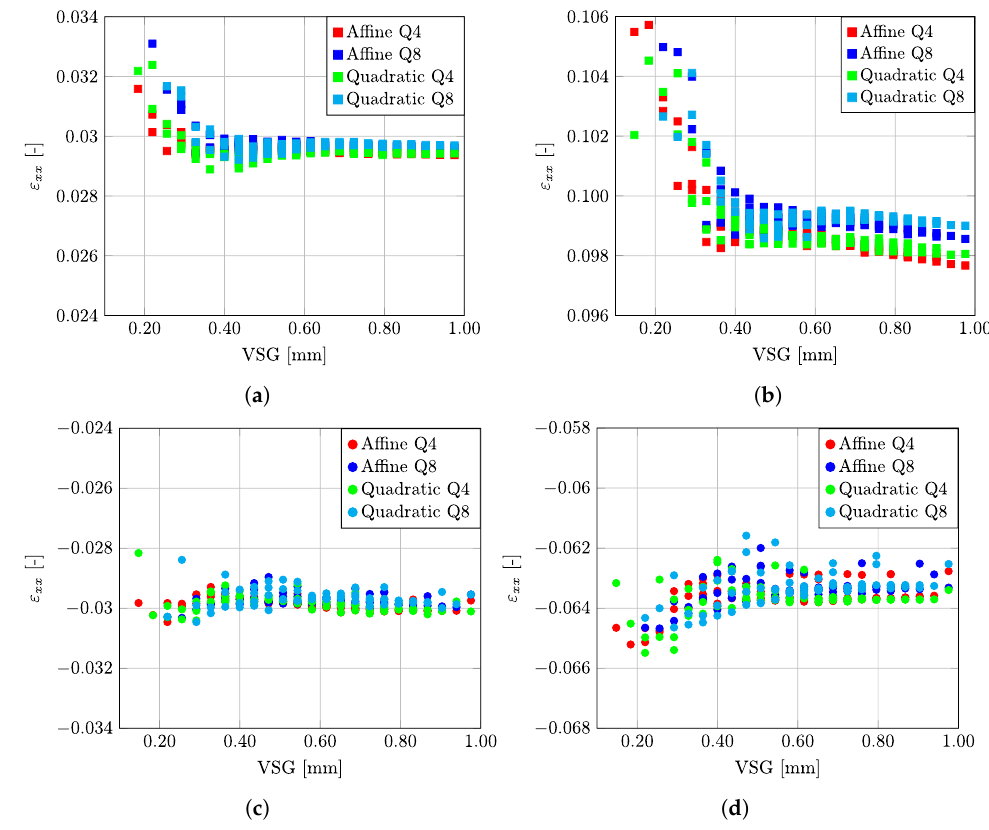
Figure 5. Evaluation of ε xx at point B (Figure 3) as a function of DIC parameters expressed with regard to Virtual Strain Gauge (VSG). ( a ) Tension-Low Strain; ( b ) Tension—High Strain; ( c ) Compression— Low Strain; ( d ) Compression—High Strain.